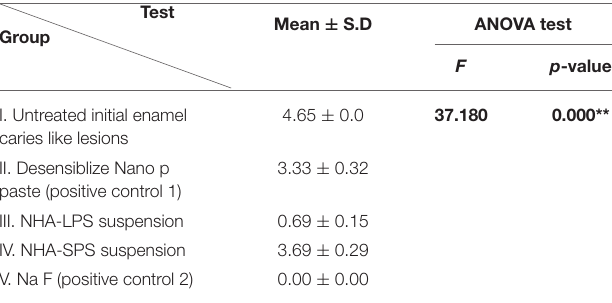
TABLE 5 | Mean values of the logarithmic number of bacterial colonies (log 10 CFU/ml), representing bacteria adhered to the enamel surface in all test groups and statistical